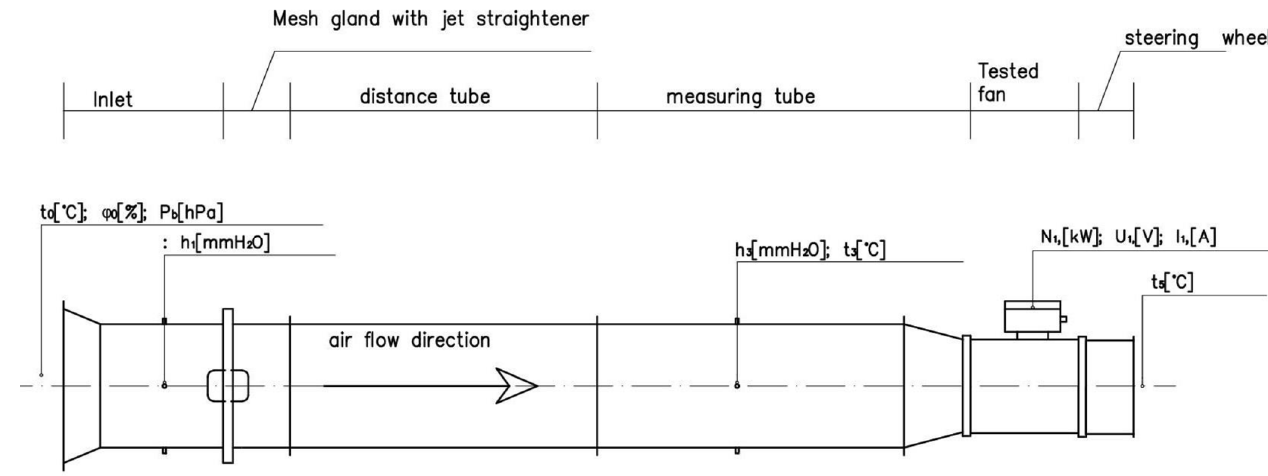
Figure 16. Scheme of the stand for testing the mine fans, type “C”.